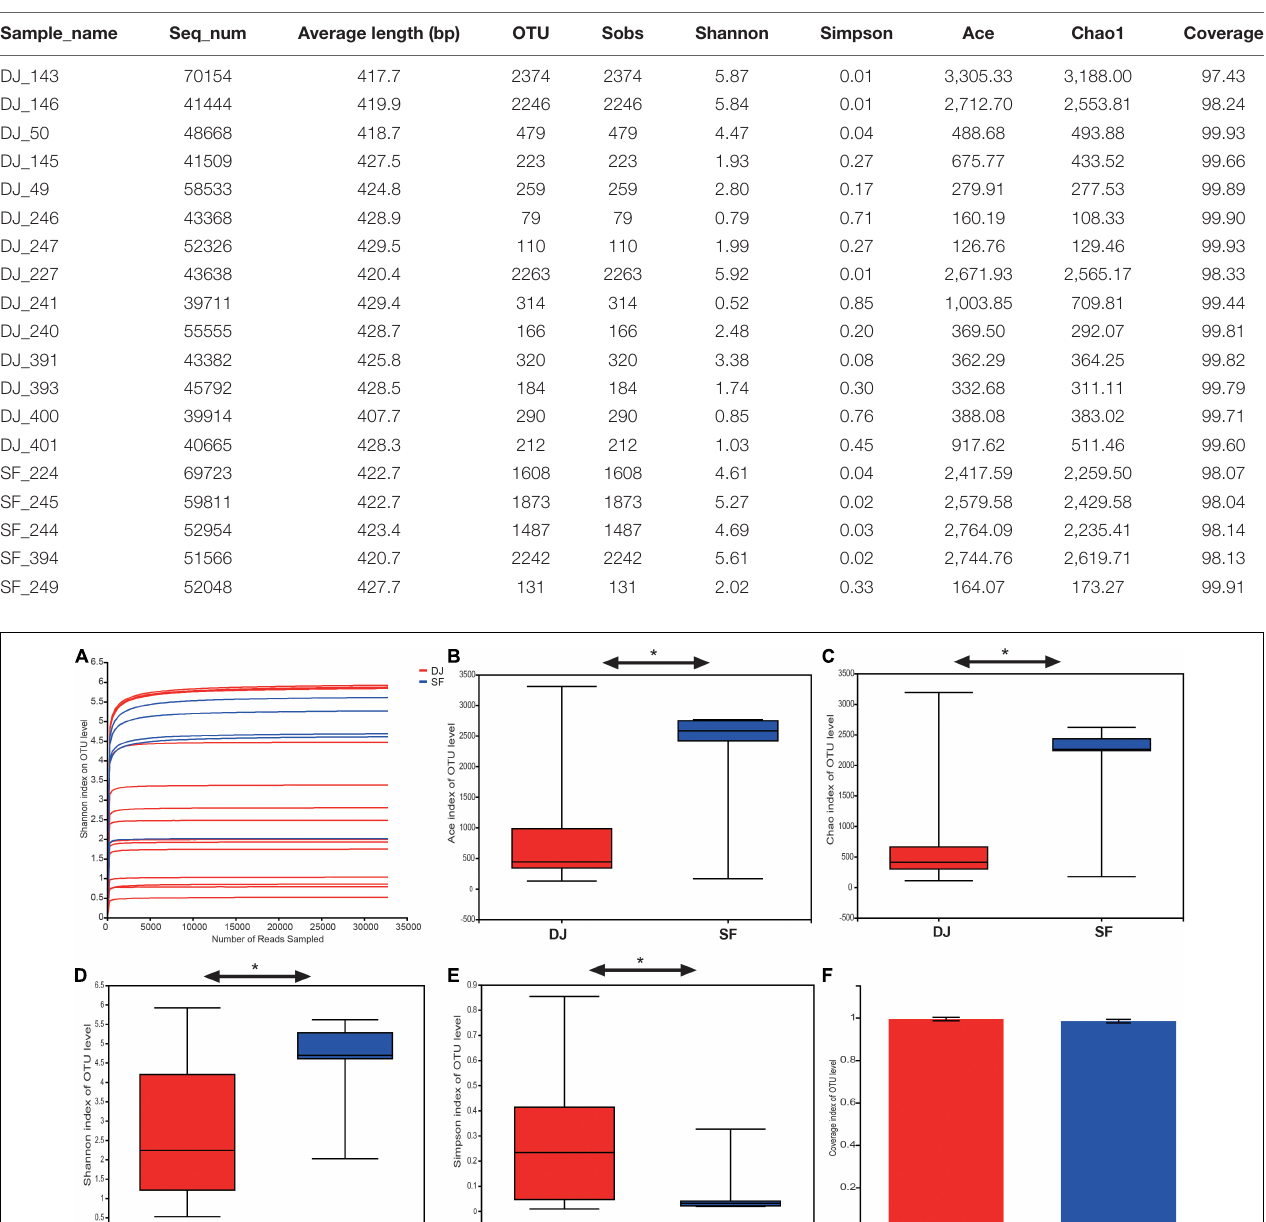
TABLE 1 | Sequence information and diversity values of Dadiang and Sufu in North China.